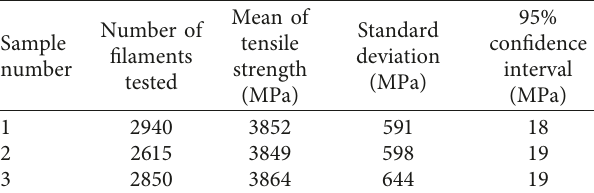
Figure 9: Mean strengths and their 95% confidence intervals obtained from single fibre tensile tests and bundle tensile tests. Table 5: Statistical parameters of normal distributions obtained from three RF500 bundle tensile tests analysis and related 95% confidence intervals.